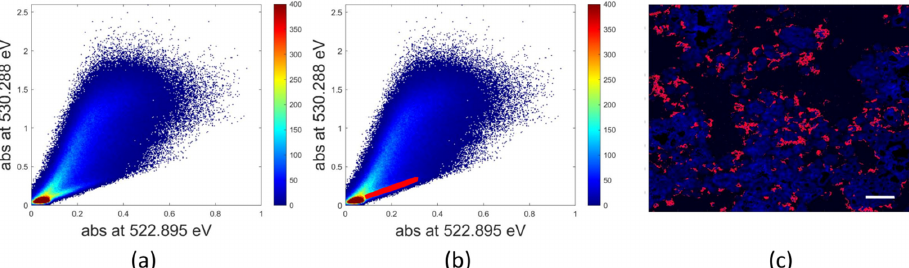
Figure 6. ( a ) Phase map where the absorbance peak value at ~530.3 eV versus the absorbance pre-edge values (~522.9 eV) is plotted. Two populations of pixels with different oxygen abundance with respect to the total material thickness are clearly distributed on two lines with different slopes. The selection of the pixels on the smaller slope line corresponding to lack of oxygen or abundance of carbon is shown in red in ( b ) and the corresponding distribution in the field of view is reported in pink in ( c ). The scale bar corresponds to 1 µm.